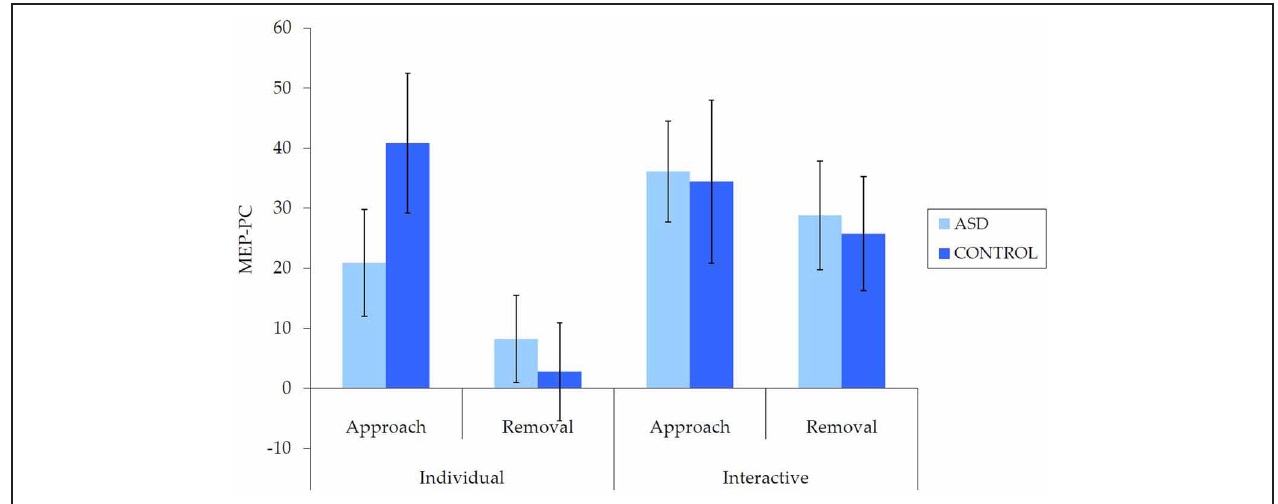
FIGURE 2 | Mean ( ± SE) (untransformed) MEP-PC by group for each condition; a greater score is indicative of enhanced